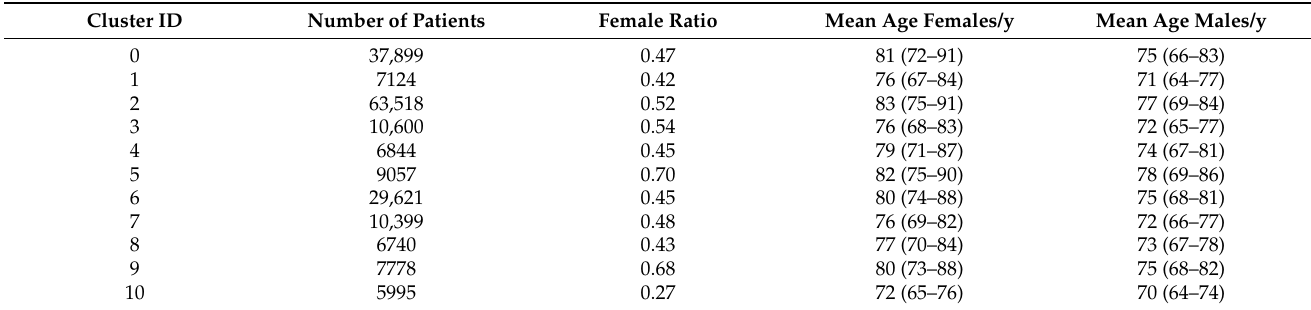
Table 2. Numbers of individuals included in the different clusters. The reported ages refer to the end of the observation period (2014). The values in brackets give lower and upper quartiles, respectively.